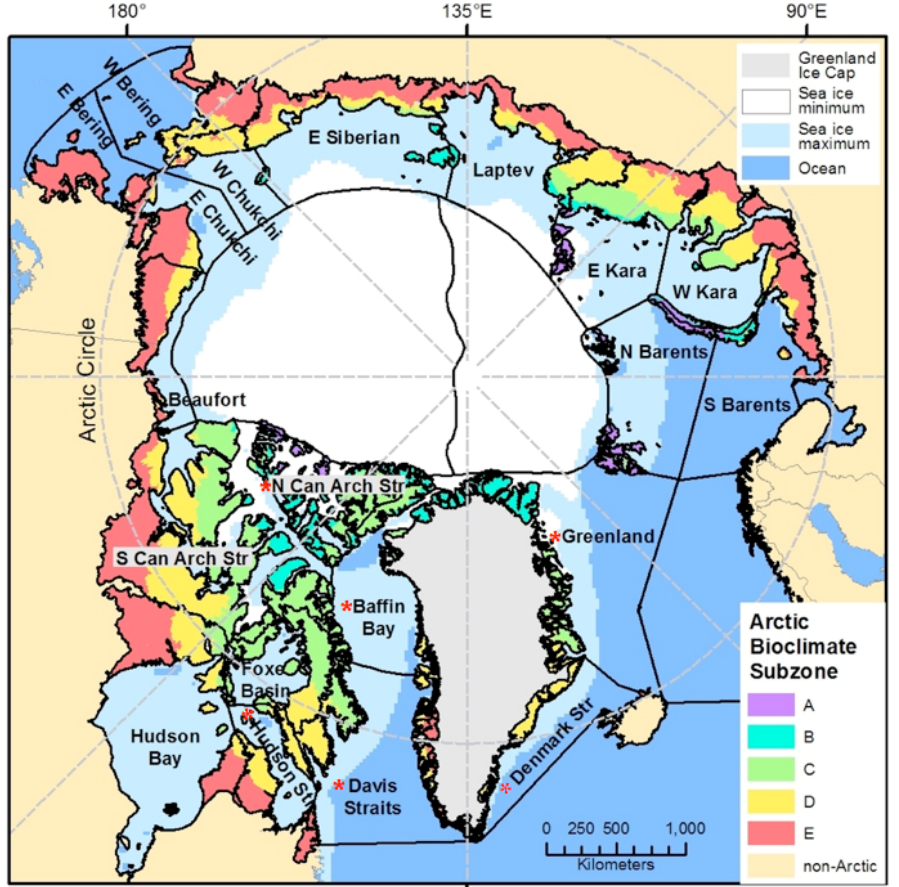
Figure 1. This map identifies oceanic and terrestrial regions (solid grey lines) of the Arctic used in the analysis. Colors over land identify the bioclimate subzones A–E of the Circumpolar Arctic Vegetation Map (CAVM) of Walker et al . [21]. The climatological (1982–2012 average) sea-ice edge indicating values at the 50% concentration level and higher are shown in light green for early May and white for late August. Regional time series are constructed for Western North America (E. Bering, E. Chukchi, Beaufort, S. Canadian Archipelago Straits, Foxe Basin, and Hudson Bay), Eastern North America (N. Canadian Archipelago Straits, Baffin Bay, Hudson Strait, Davis Strait, Denmark Strait, and Greenland), and Eurasia (N. Barents, S. Barents, W. Kara, E. Kara, Laptev, E. Siberian, W. Chukchi, W. Bering). A red star identifies Eastern North America